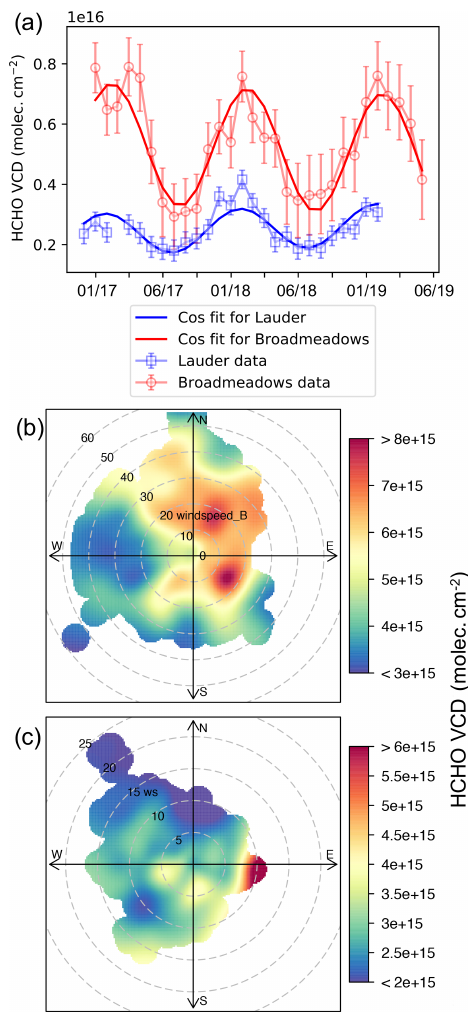
Figure 5. (a) Time series of monthly averaged MAX-DOAS formaldehyde VCDs at Broadmeadows (red points) and Lauder (blue squares). Cosine fits to each dataset are also plotted (solid lines), representing the seasonal cycle of HCHO at each location. (b) Polar bivariate plot showing the relationship between HCHO VCD and wind speed (in kmh − 1 ) and direction at Broadmead- ows across the measurement period. (c) Same as panel (b) but for